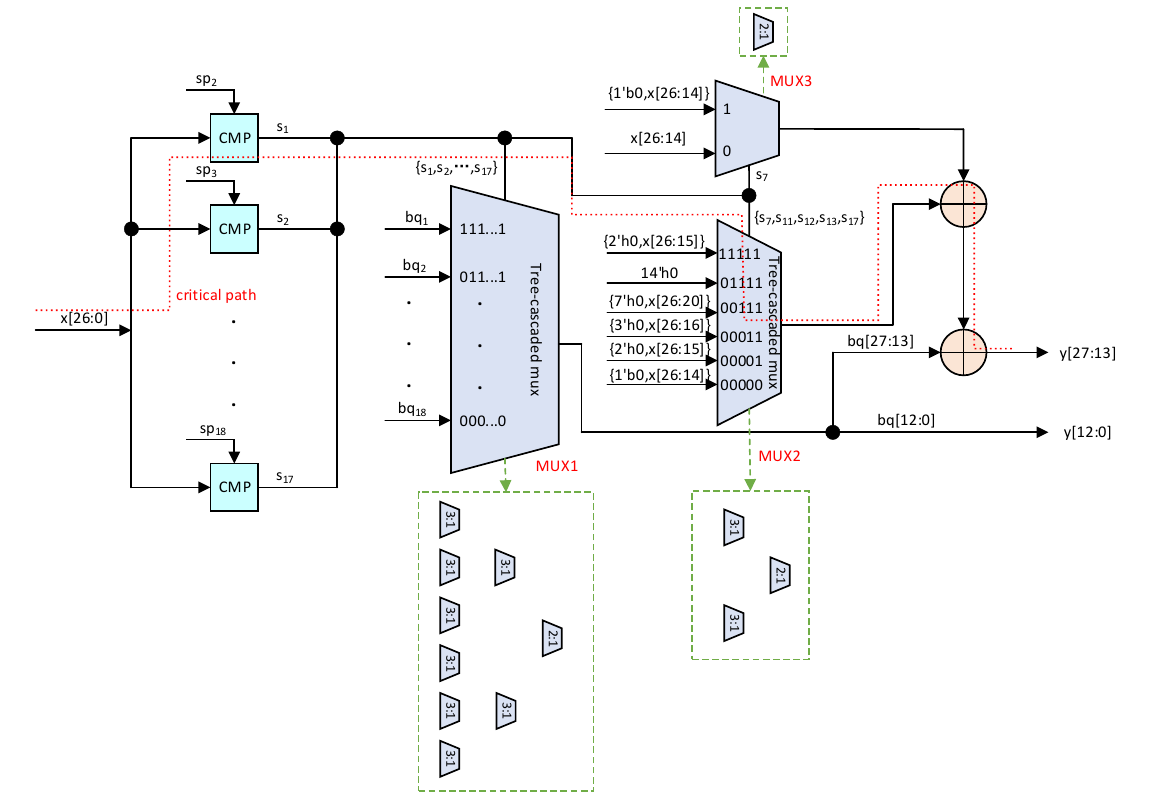
Figure 5. The hardware architecture for 2 x (iw = 27, qw = 14, kw = 2, MAE def = 1.29 × 10 − 3 ). Seventeen parallel comparators are used to determine the location of the input data.